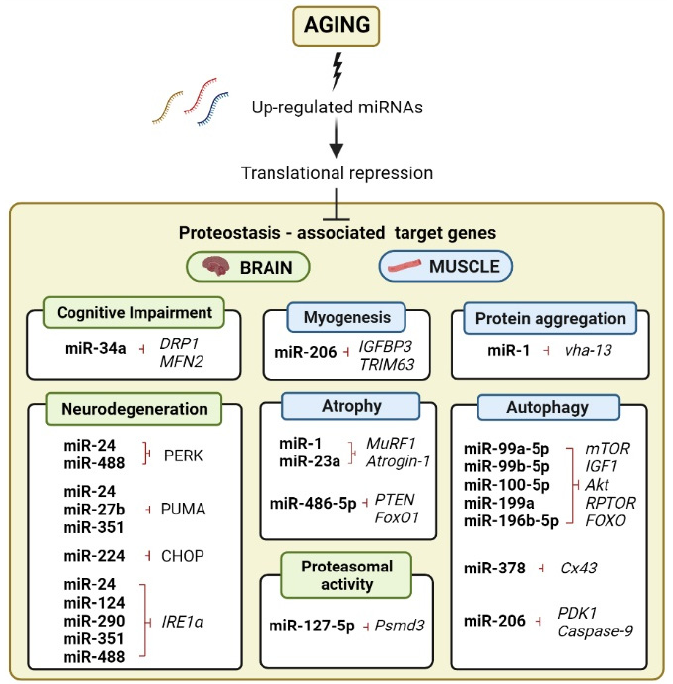
Figure 1. Role of miRNAs in proteostasis imbalance during mammalian aging. Aging can lead to the upregulation of miRNAs in brain and skeletal muscle tissue, repressing the translation of proteostasis-associated target genes. MiR-34a, miR-24, miR-27b, miR-124, miR-224, miR-290, miR-351, miR-488, and miR-127-5p have proteostasis-associated target genes, mainly pertaining to the unfolded protein response (UPR) and the ubiquitin–proteasome system (UPS), which are implicated in mammalian brain aging (green headings). MiR-1, miR-23a, miR-99a-5p, miR-99b-5p, miR-100-5p, miR-199a, miR196b-5p, miR-206, miR-378, and miR-486-5p modulate target genes that are part of the autophagy–lysosomal pathway (ALP), with many genes belonging to the AKT/mTOR/FOXO signaling pathways. These miRNAs have been linked specifically to skeletal-muscle aging in mammals in the non-disease context (blue